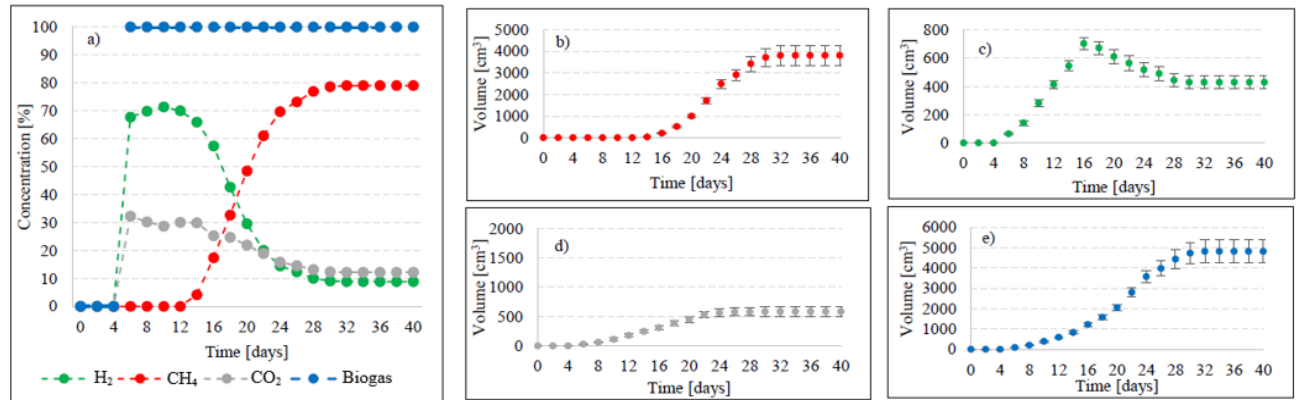
Figure 6. Changes in concentrations of biogas fractions in V4 ( a ); total volumes of CH 4 ( b ), H 2 ( c ), CO 2 ( d ), and biogas ( e ).